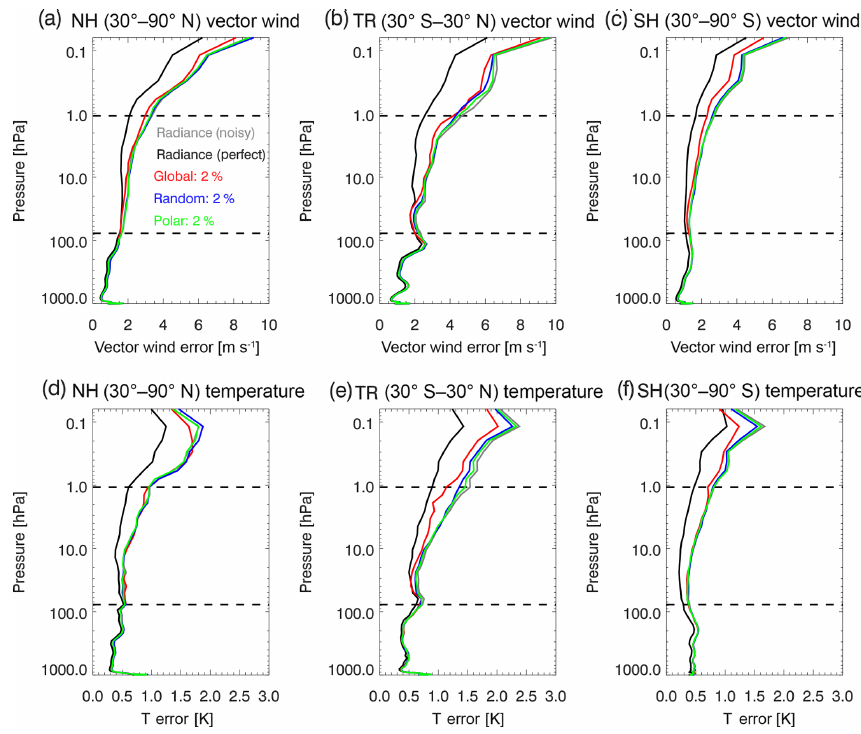
Figure 24. The rms vector wind errors (ms − 1 ) averaged from 25 November to 1 December 2014 for (a) NH, (b) TR, and (c) SH and rms temperature errors (K) for the (d) NH, (e) TR, and (f) SH. Colored lines are for ozone assimilation experiments with noisy radiance and ozone data with 2% error using the sampling pattern of global (red), random (blue), and polar (green). Grey lines are for radiance-only assimilation for noisy and perfect data (same as in Fig. 20). Horizontal dashed lines indicate vertical range of assimilated stratospheric ozone observations. See Table 1, Sect. 5.1 and